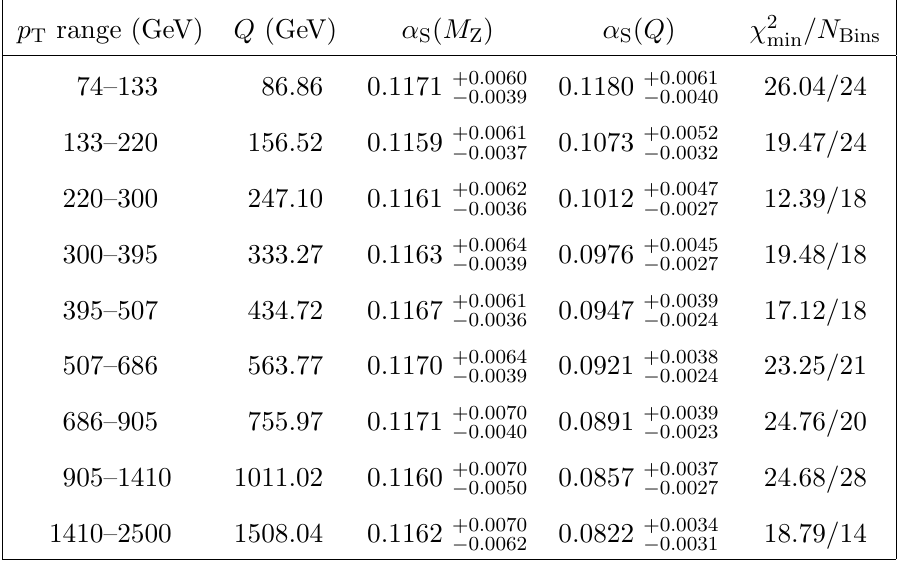
Table 5 . The extracted (cid:11) S ( M Z ) values, the corresponding (cid:11) S ( Q ) values at the Q scale for each p T range, and (cid:31) 2 =N Bins are shown. Uncertainties are given for both (cid:11) S values. min The Q scale corresponding to each p range is evaluated as the cross section T